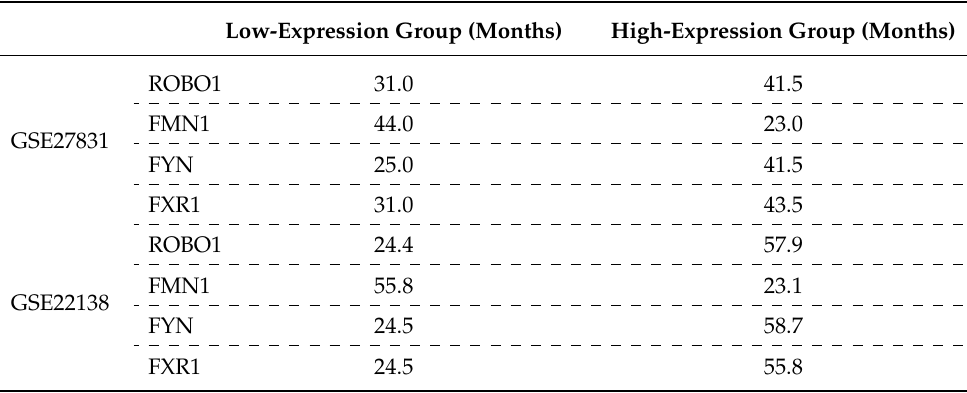
Table 4. The median metastasis-free survival times of the low-expression and high-expression groups of the hub genes.